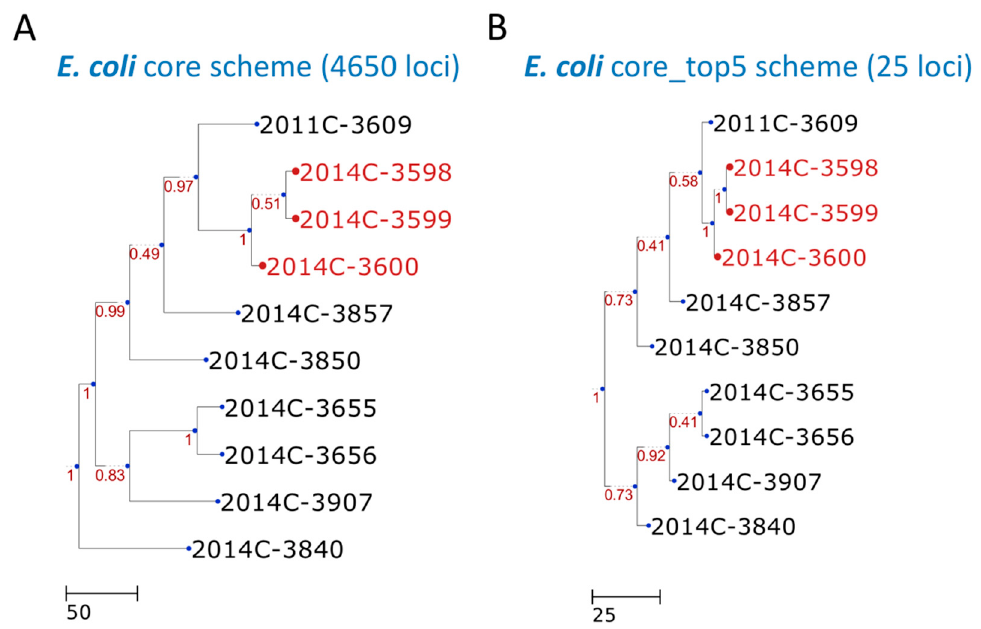
Figure 3. Dendrogram constructed with cgMLST profiles for ten Escherichia coli isolates. The cgMLST trees were generated according to the ( A ) core scheme (4650 loci) and ( B ) core_top5 scheme (25 loci). The outbreak or event-related taxa are colored red. The core scheme refers to the core genome scheme generated in step 2 by the PGAdb Builder. The core_top5 scheme is a subset of the core scheme that unites the five most discriminatory loci for each split. The scheme was generated in step five by the Loci Extractor.